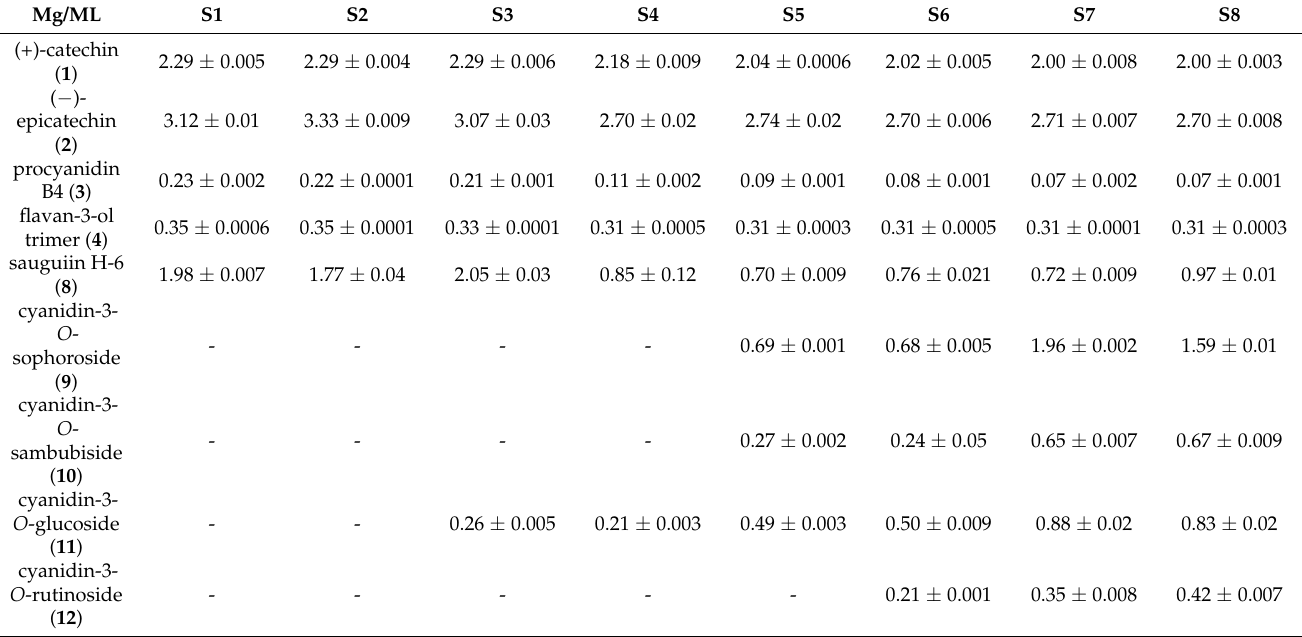
Table 3. Polyphenol contents (mg/100 mg of DW) in raspberry fruit extracts at various stages of maturation.